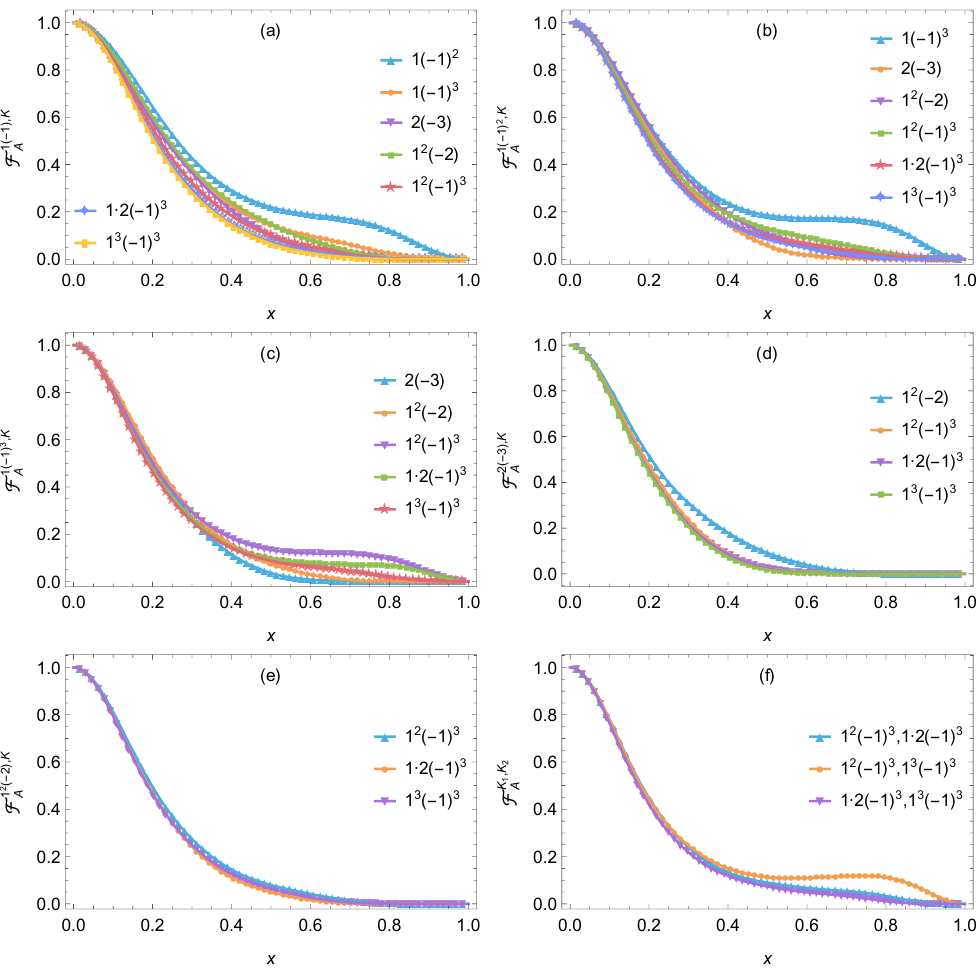
Figure 6 . The product F X 1 and the corresponding quantities in the gapless limit of the harmonic chain (symbols). We have set m = 10 − 5 , L = 64